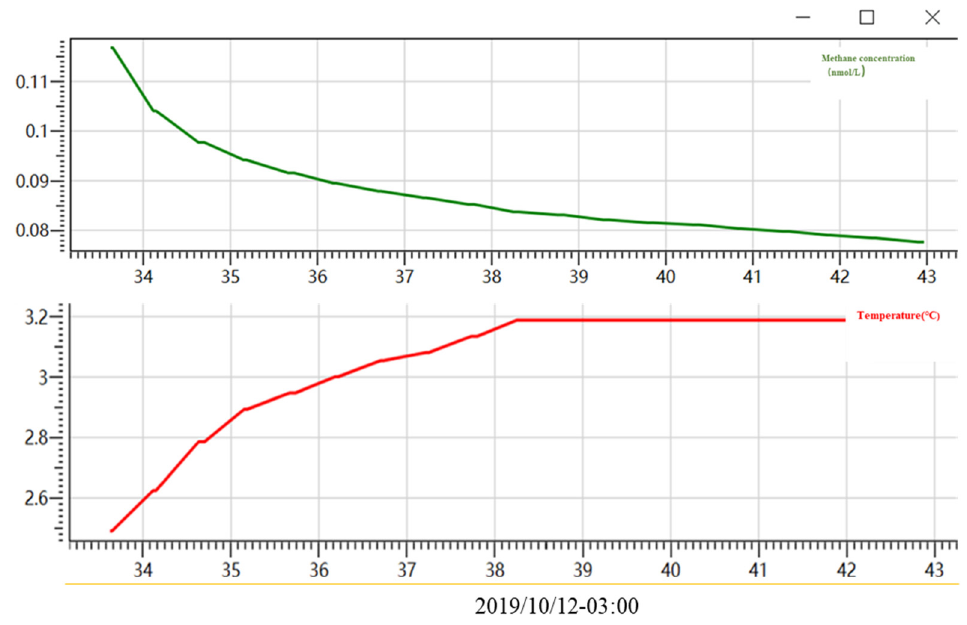
Figure 8. Test data at a water depth of 1250 m (18264–18187 sound communication module paired successfully).